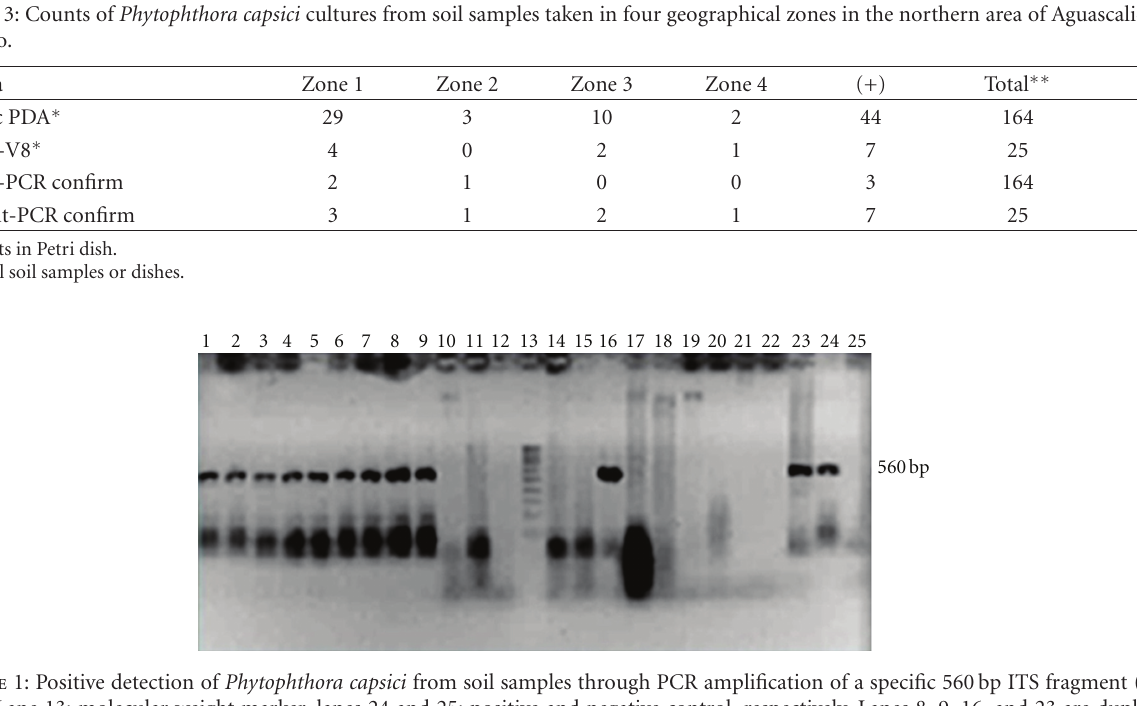
Table 3: Counts of Phytophthora capsici cultures from soil samples taken in four geographical zones in the northern area of Aguascalientes, Mexico.